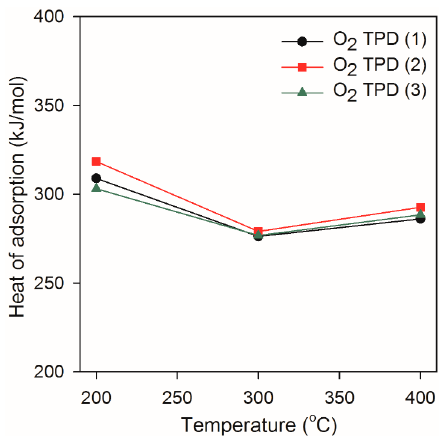
Figure 6. Averaged adsorption heats of oxygen for adsorption temperatures of 200 °C, 300 °C, and 400 °C over 2% Pt/Al 2 O 3 catalyst. Experimental procedures are described in Section 3.